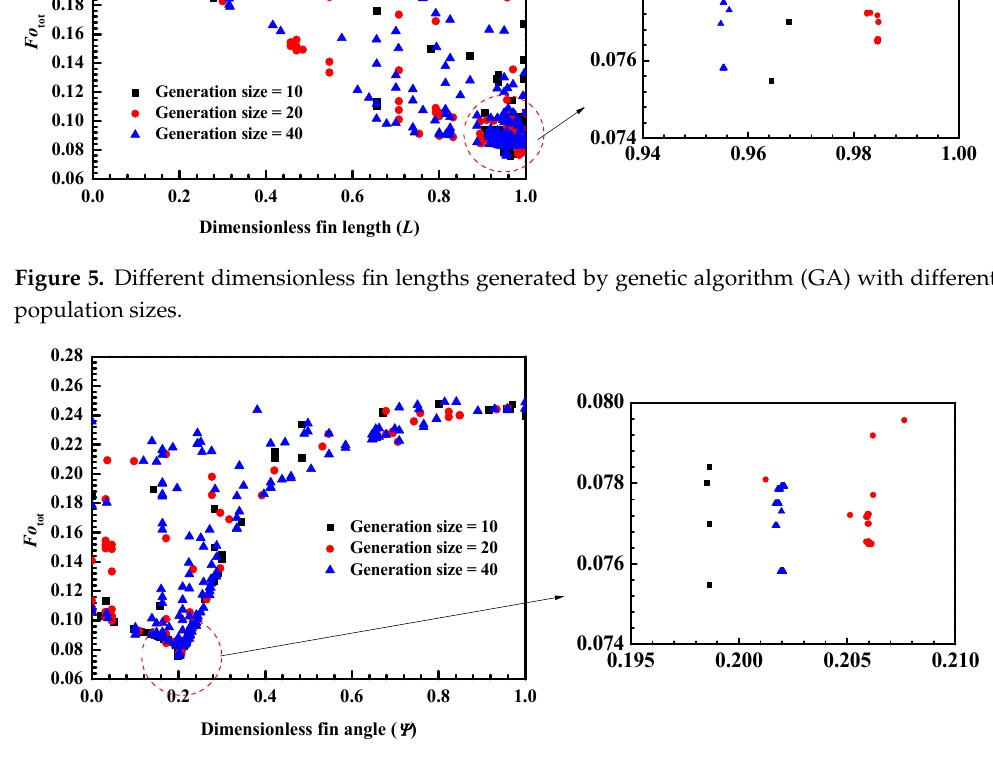
Figure 6. Different dimensionless fin angles generated by genetic algorithm (GA) with different population sizes.